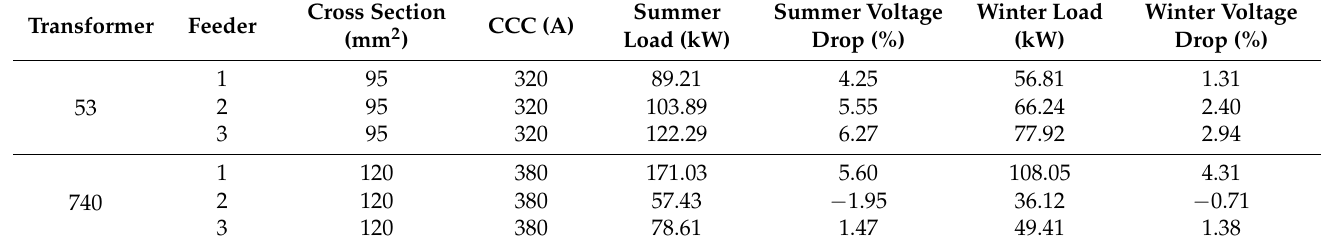
Table 3. Network data of block No. 1 in Aqaba.